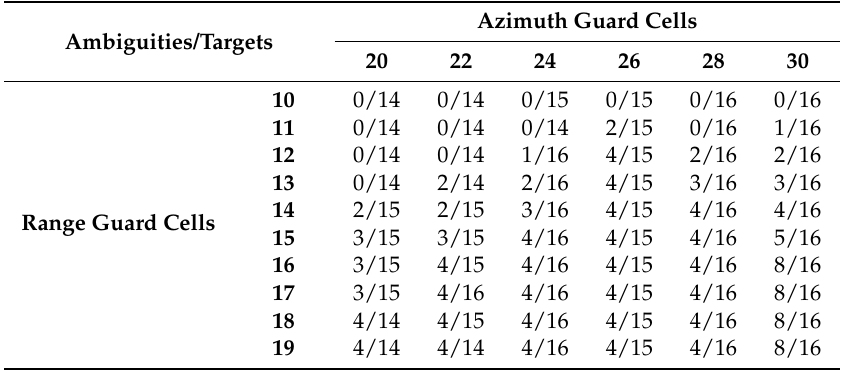
Table 3. Numbers of ambiguity/target detections versus range/azimuth guard cell